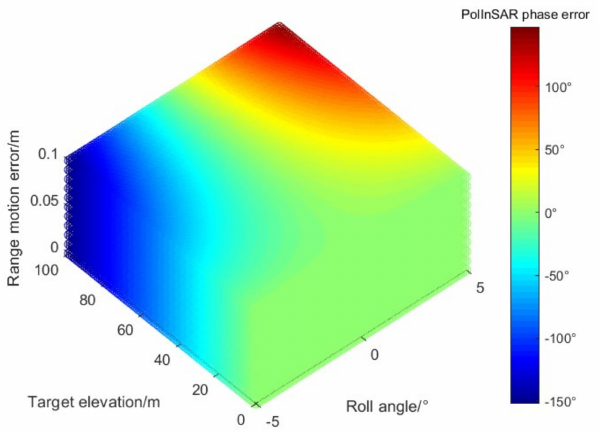
Figure 13. Polarimetric interferometry phase